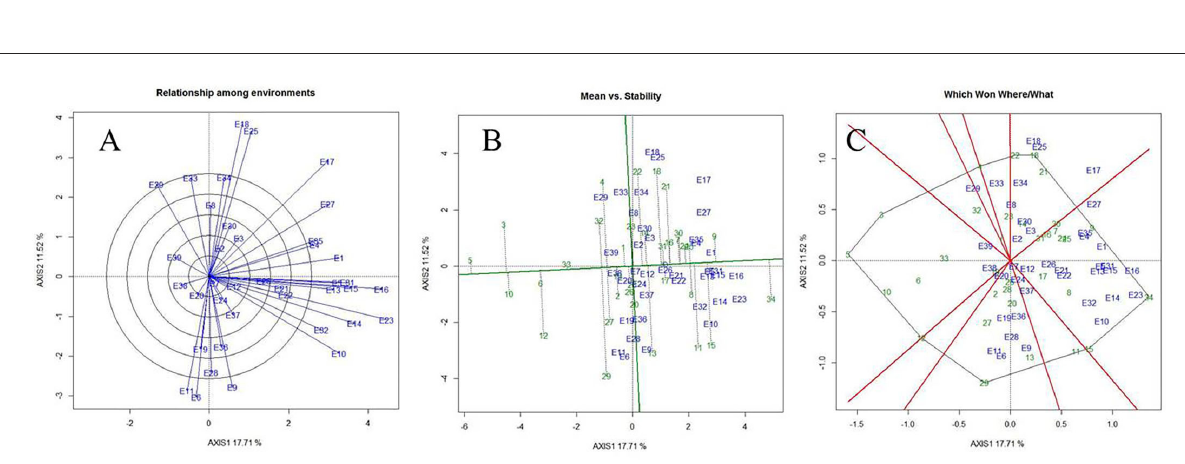
2). The biplot was based on “Column metrics preserving’, =